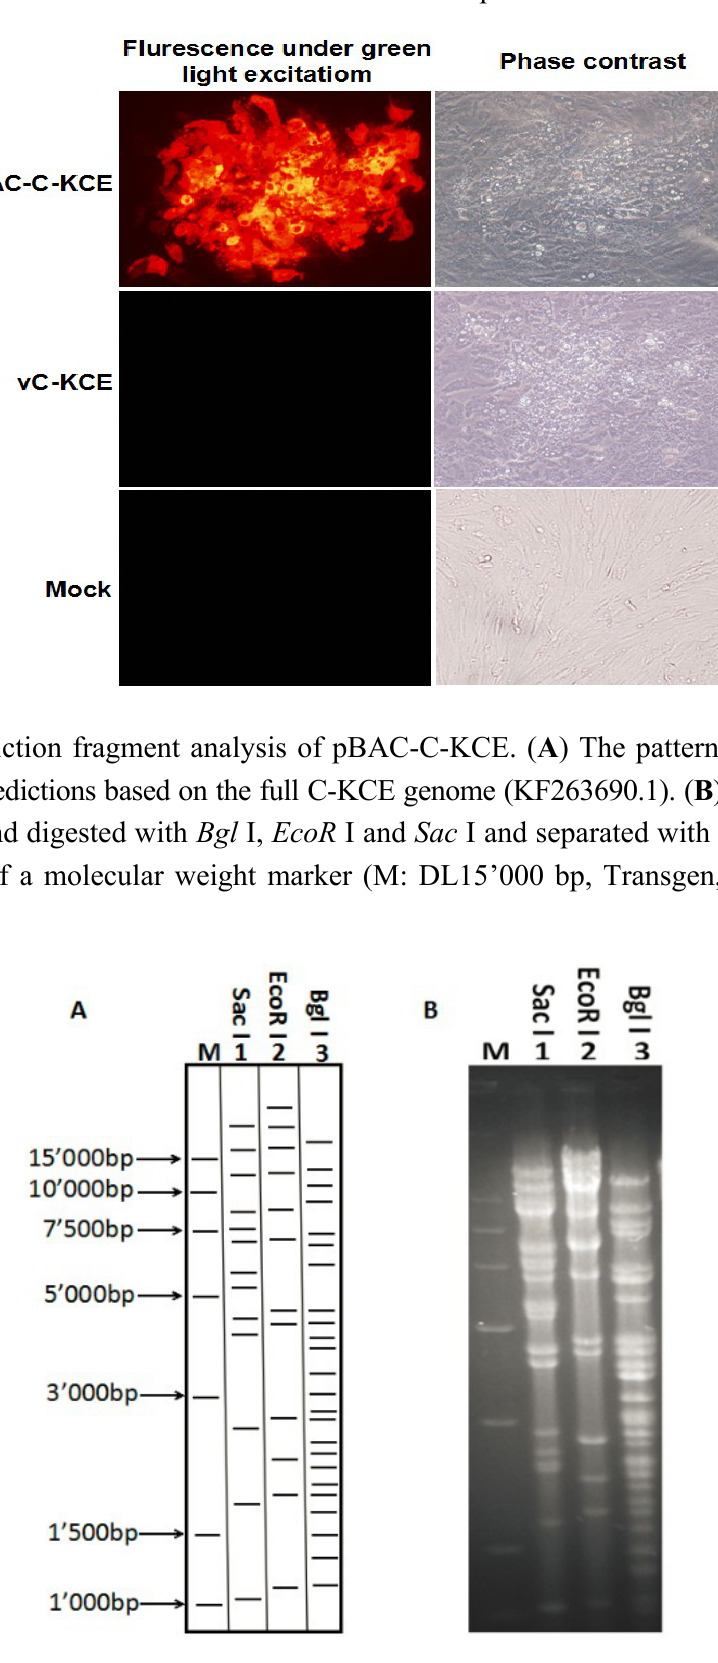
Figure 2. Plaques of recombinant vBAC-C-KCE-E, parental C-KCE virus and mock. Plaques are exposed to the excitation of 558 nm and the phase contrast.